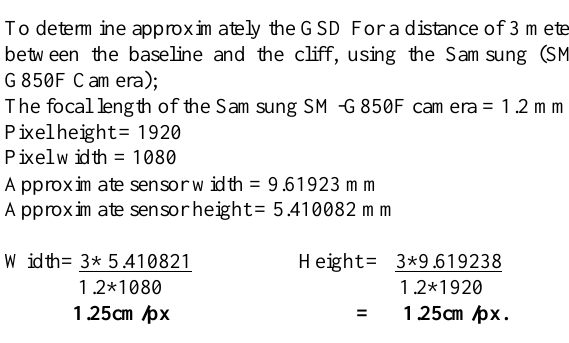
Figure 4. Dense Point Cloud obtained from Four Vertical Camera Angle